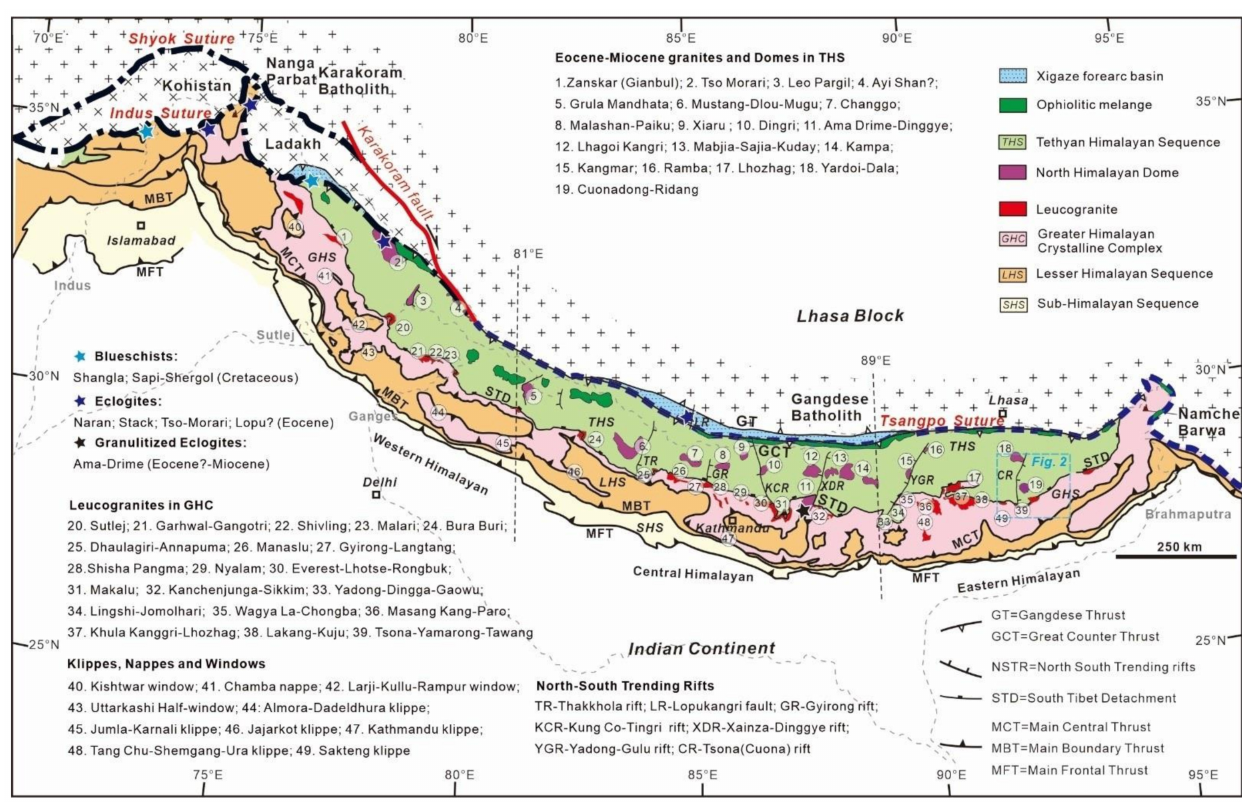
Figure 1. Map of the Himalayan orogenic belt showing the distribution of leucogranites, gneiss domes, tectonic zones and the Cuonadong deposit